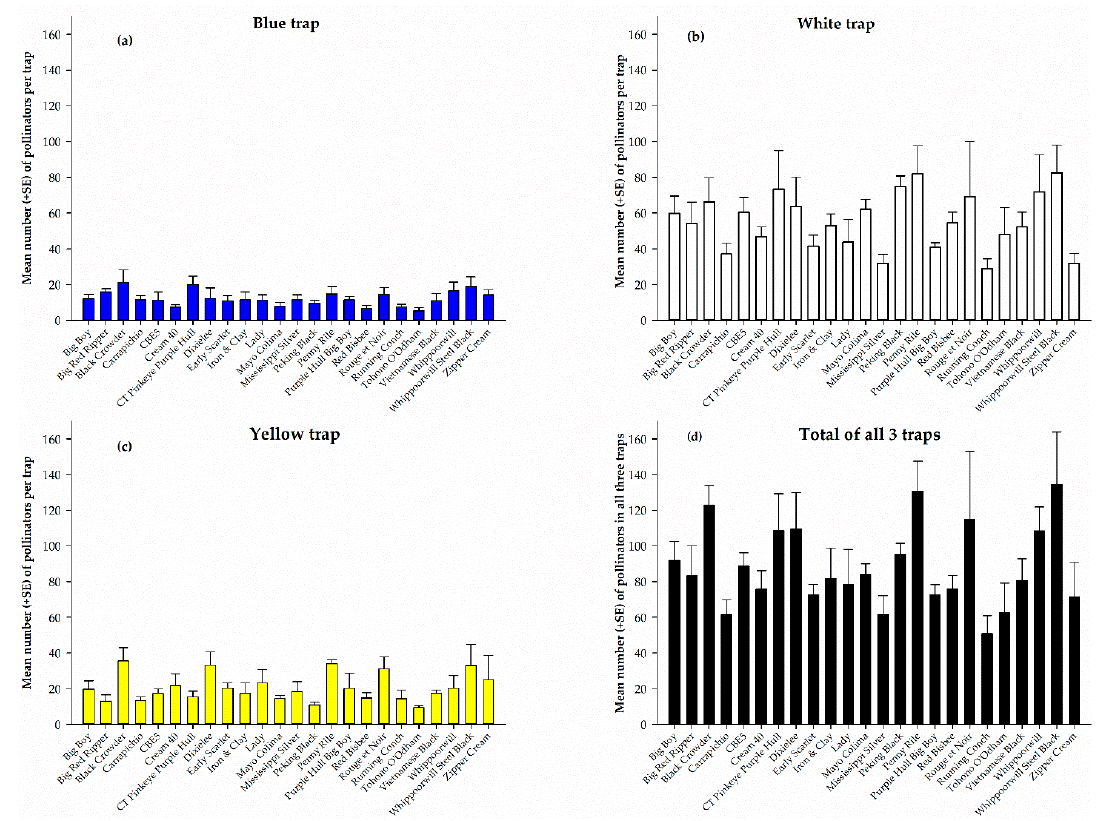
Figure 1. Pollinators captured in blue ( a ), white ( b ), and yellow ( c ) pan traps and total pollinators in all three traps ( d ) on different cowpea varieties for the entire sampling period.